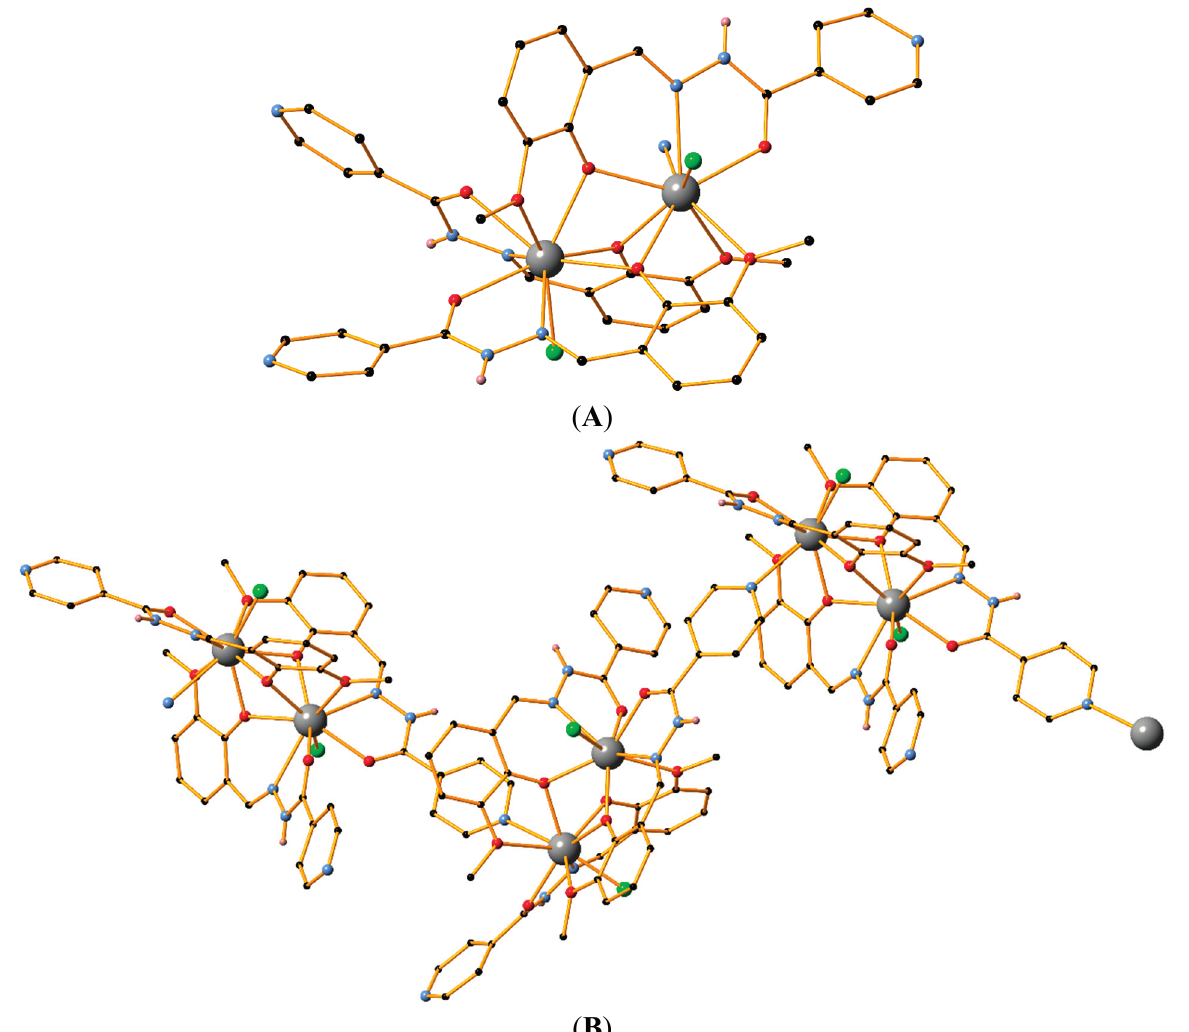
Figure 2. ( A ) The structure of compounds 2-Dy , 2-Gd and 2-Y . X = Dy, Gd, Y; ( B ) Part of the 1D framework of compounds 2-Dy , 2-Gd and 2-Y . Certain H atoms and all solvent molecules are omitted for clarity. Colour code X (grey), Cl (green), C (black), N (light blue), O